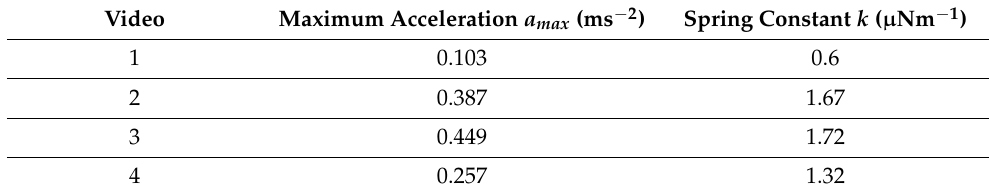
Table 2. Bolas droplet acceleration and spring constants during a flick.